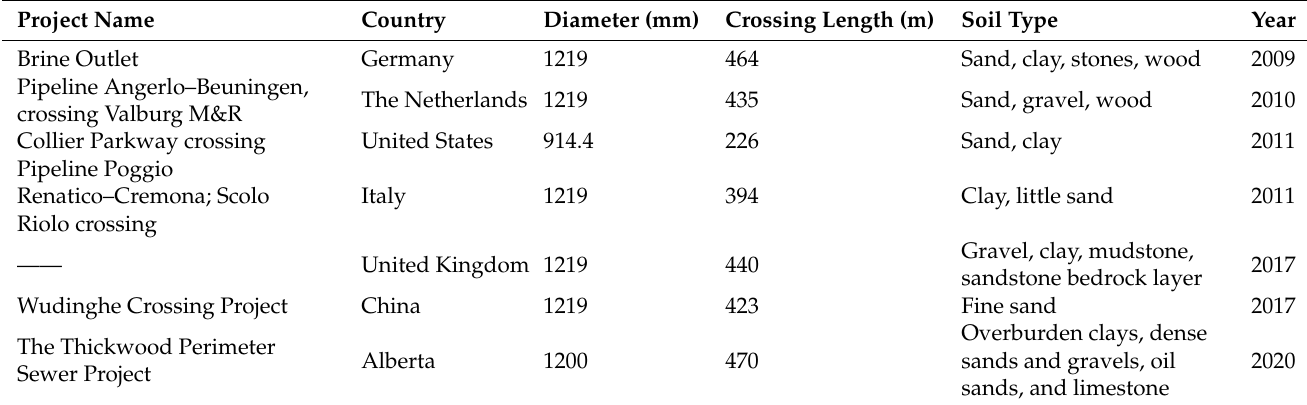
Table 1. Construction cases of rapid jacking and pipelines laying method.